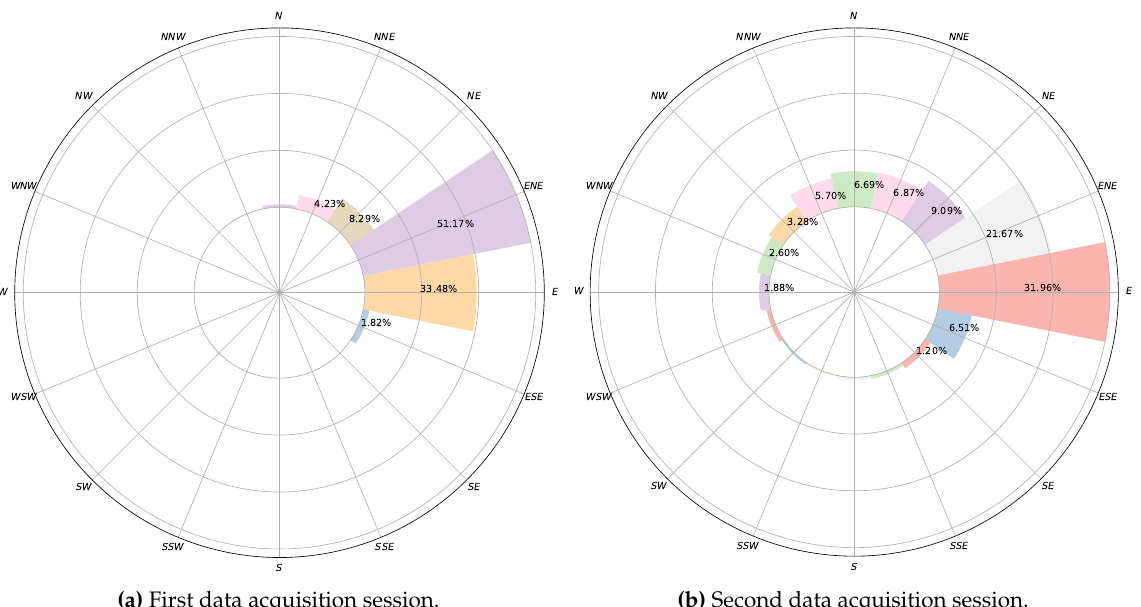
Figure 16. Wind direction distributions in both experimental sessions; in ( a , b ), values for wind directions with percentages less than 1% are not